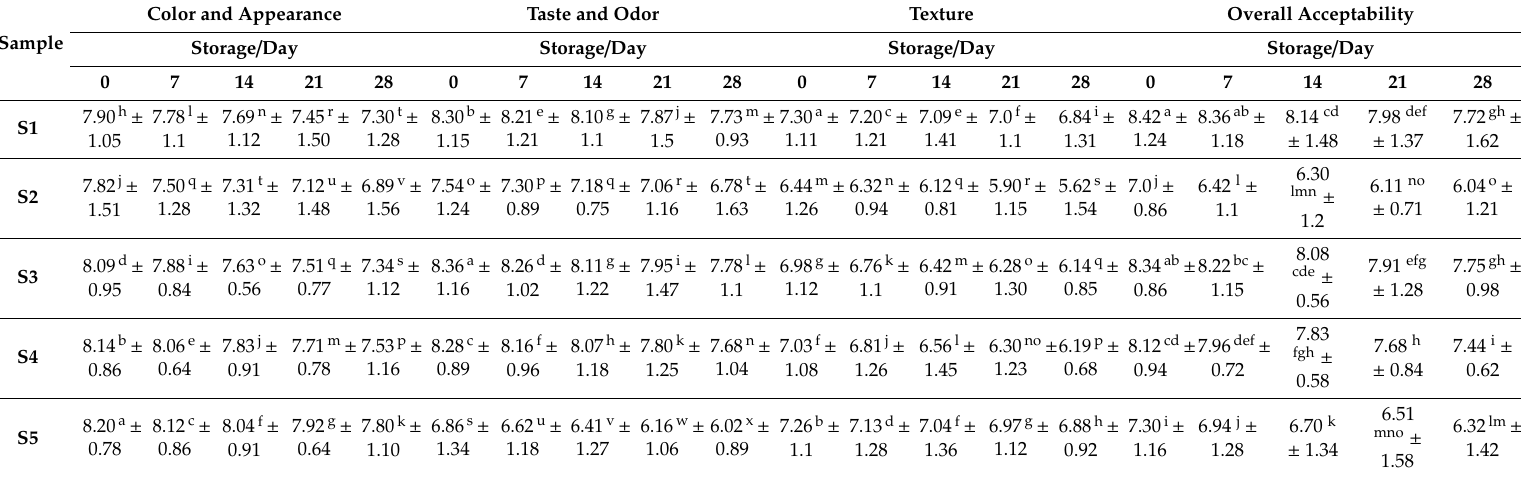
Table 3. Mean sensory scores with standard deviation given by panelists (n = 12) for each yogurt sample on a hedonic scale of nine-points.